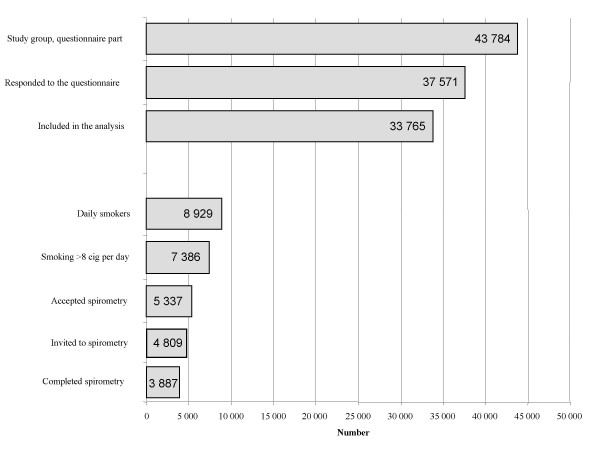
Number of participants in each step of the study.